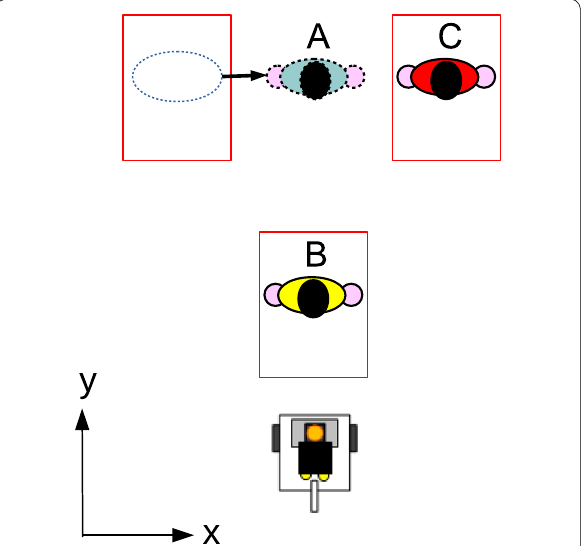
Fig. 12 An example of tracking failure after the re-detection of the player